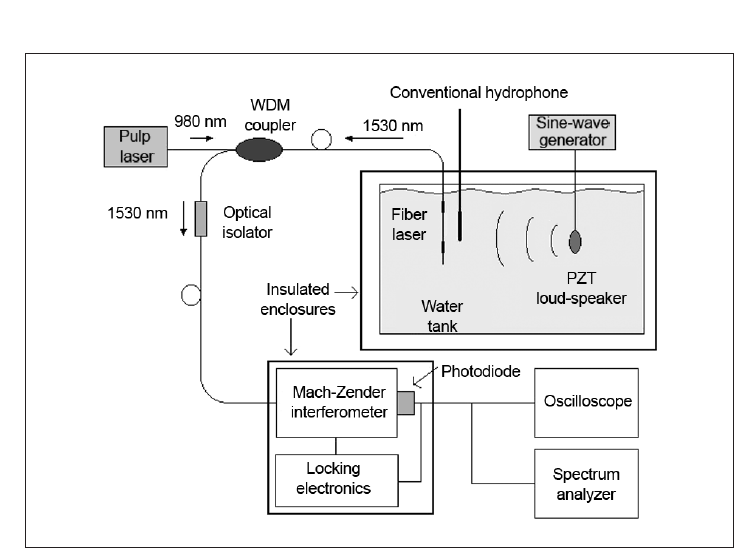
Fig. 6. Experimental